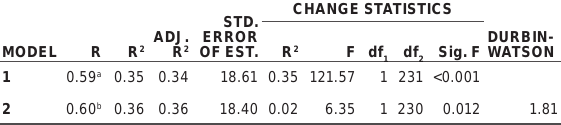
TABLE 8 Summary statistics of Stepwise regression of predictor variables Sense of Coherence and External Locus of Control on Stress